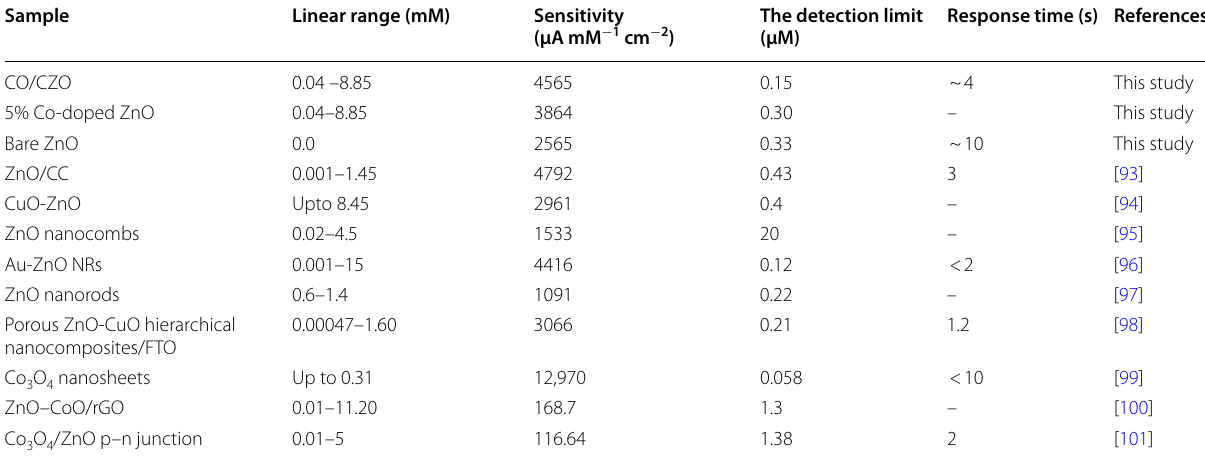
Table 2 Performance comparison of CO/CZO based glucose sensors with ZnO, CoO and their heterostructure either with a metal or a metal-oxide reported previously